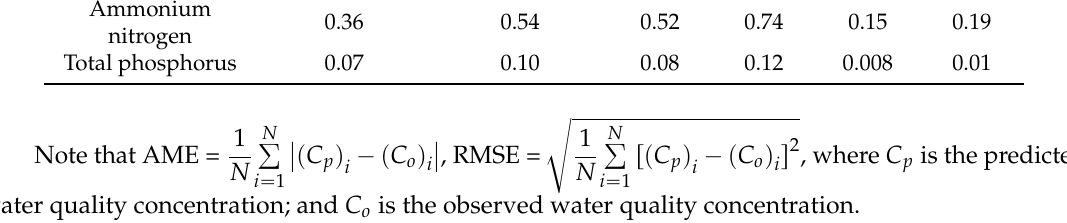
Table 3. Statistical error between simulated and measured water quality state variables on 3 March 2011. Water